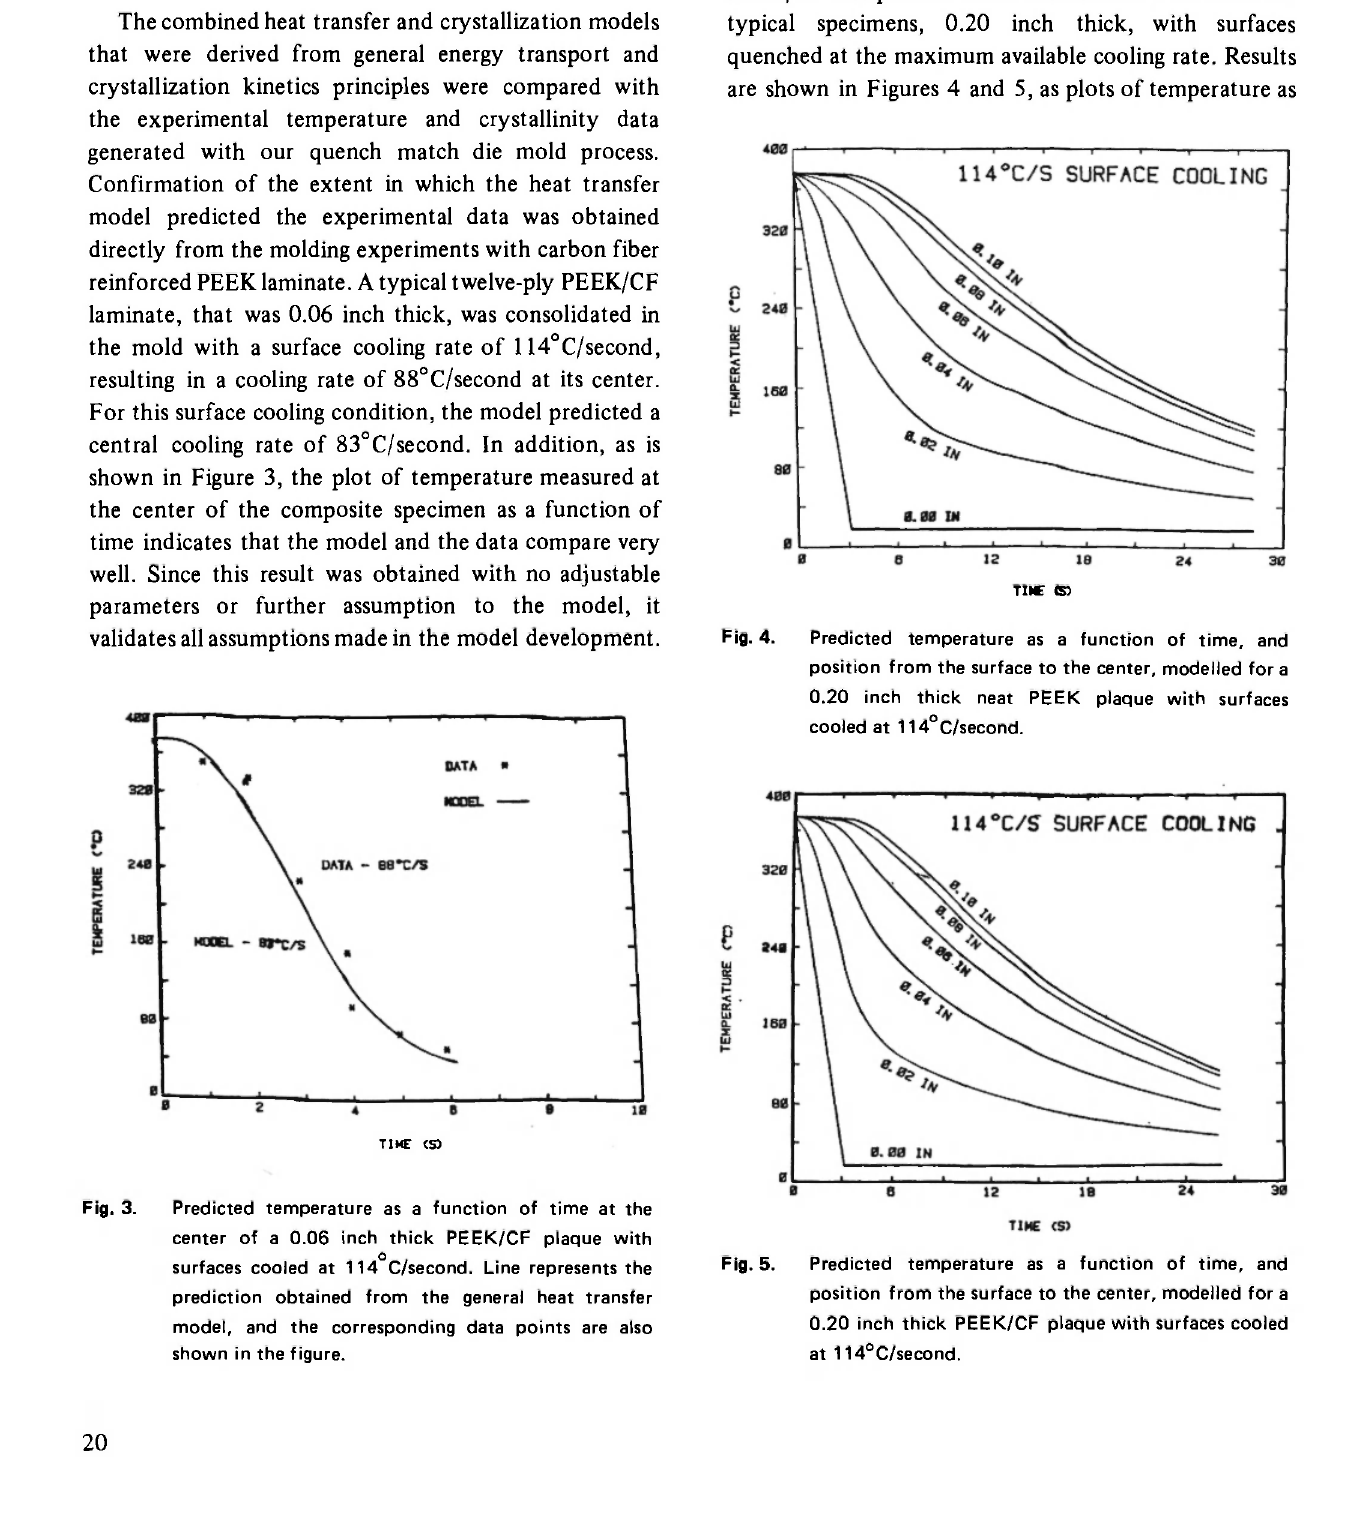
Fig. 3. Predicted temperature as a function of time at the center of a 0.06 inch thick PEEK/CF plaque with ο Fig. 5. Predicted temperature as a function of time, and surfaces cooled at 114 C/second. Line represents the position from the surface to the center, modelled for a prediction obtained from the general heat transfer 0.20 inch thick PEEK/CF plaque with surfaces cooled model, and the corresponding data points are also at 114° shown in the figure.